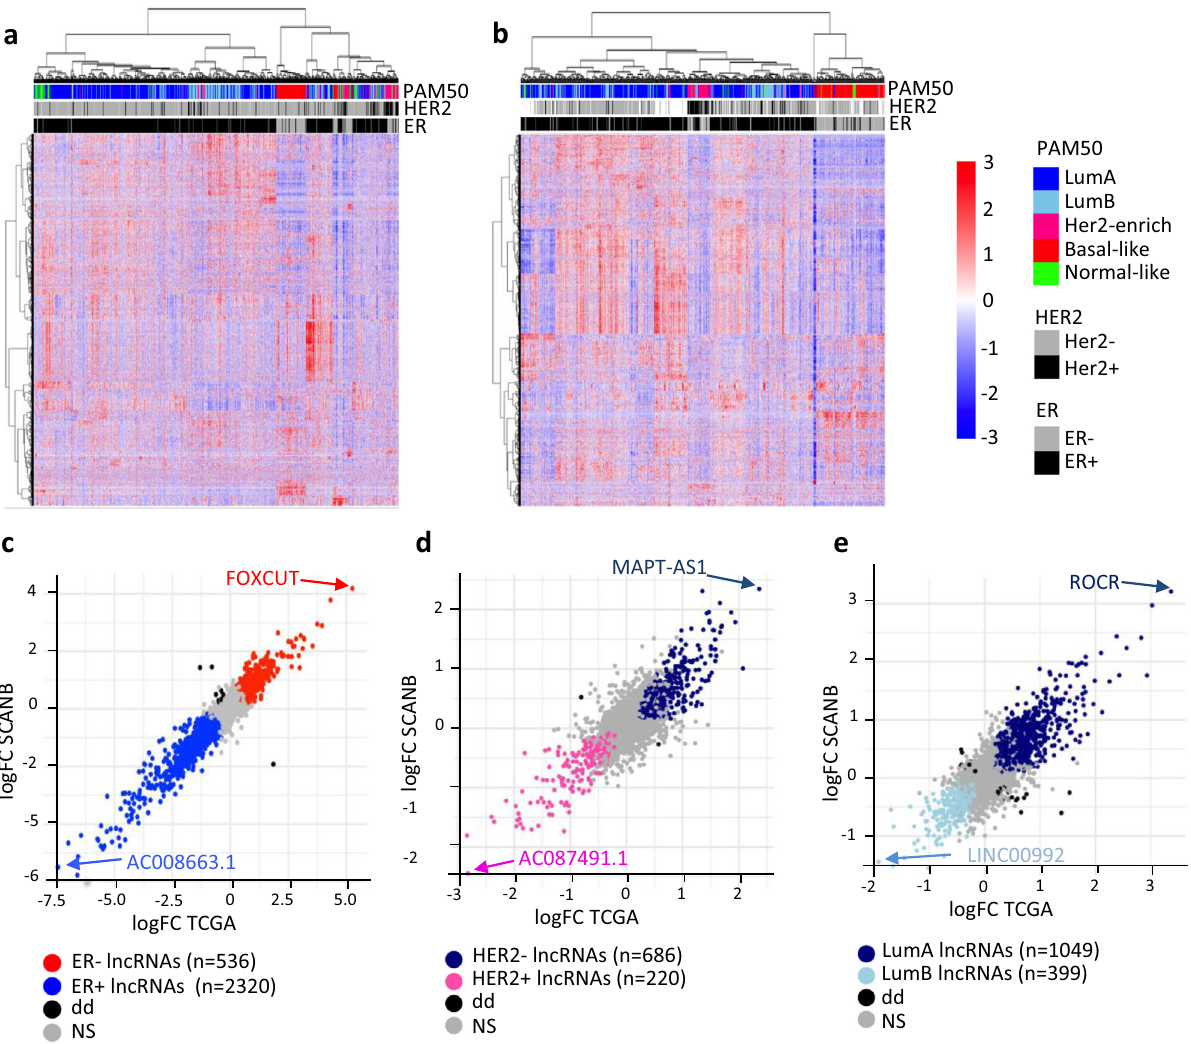
Fig. 1 lncRNA expression in breast cancer subtypes. Hierarchical clustering of log2(TPM + 1) of 4108 lncRNAs expressed above fi ltering thresholds (see Methods) in the SCAN-B ( a ), and TCGA-BRCA ( b ) cohorts. Estrogen Receptor (ER) and Her2 status, as well as PAM50 subtypes are annotated at the top of the heatmap. The expression gradient (blue to red) represents scaled and centered log2(TPM + 1). c – e Dot plot of the log Fold Change (FC) from the differential expression analysis using a fi tted Limma model (lm fi t) and moderated t-statistic (eBayes) between patients of different subtypes in SCAN-B (x- axis) and TCGA-BRCA (y-axis). Each dot represents a lncRNA, while the colour indicates the subtype with the highest expression c ER positive (blue) and ER negative (red), d Her2 negative (dark blue) and Her2 positive (pink). e Luminal A (dark blue), and Luminal B (light blue). Gray dots are lncRNAs that are not signi fi cantly differentially expressed, while black dots represent lncRNAs with opposite fold change (FC) in the two cohorts. The number of patients in each clinical group were as follows: ER positive ( n = 2409 and n = 807), ER negative ( n = 504 and n = 237), Her2 positive ( n = 458 and n = 114), Her2 negative ( n = 2845 and n = 650), Luminal A ( n = 1769 and n = 562), and Luminal B ( n = 766 and n = 209) in SCAN-B and TCGA-BRCA (Supplementary Fig. 4a) between lncRNA ( n = 4108) and protein coding genes´ mRNA ( n = 17060). Retaining the signi fi cant Spearman correlation coef fi cients of all lncRNA-mRNA associa- tions in both cohorts (Bonferroni corrected p -value < 0.05), led to n = 15407856 signi fi cant correlations. On average, each lncRNA was signi fi cantly correlated with the expression of 95 mRNAs (Supplementary Fig. 4b), while each mRNA was on average correlated with 20 lncRNAs (Supplementary Fig. 4c). Among the lncRNAs associated to the expression of the highest number of mRNAs, we found a non-coding RNA activated by DNA damage ( NORAD ), known to regulate genome stability 22 , as well as other lncRNAs with known function in DNA-damage response, including the estrogen responsive LINC01488 23 .